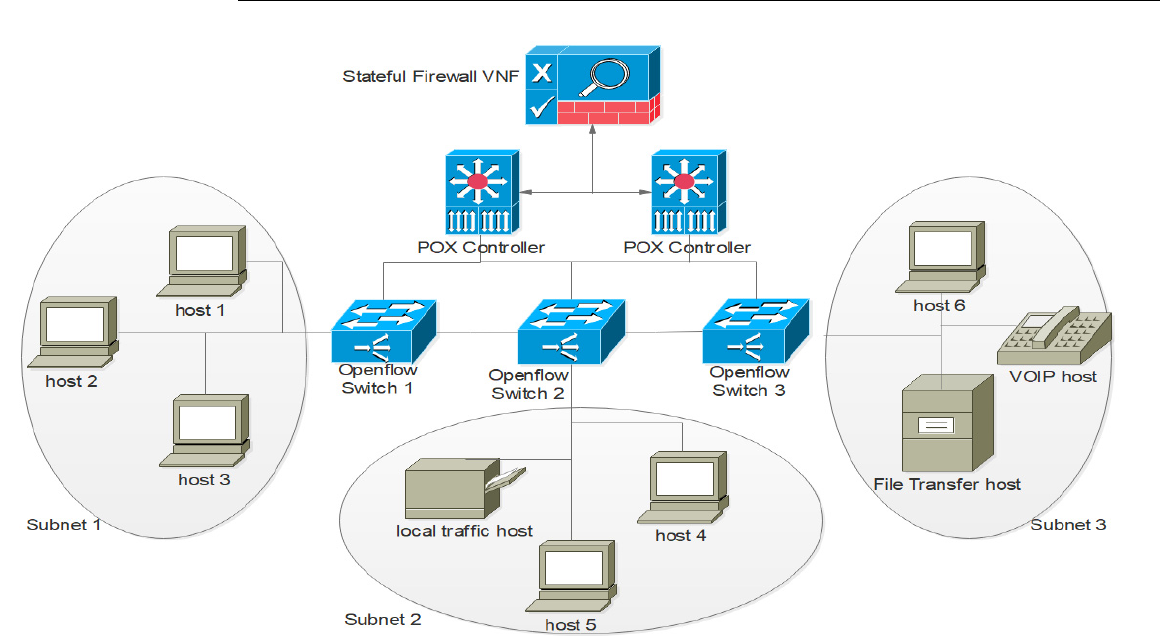
Figure 6. SDNFV Network Topology.